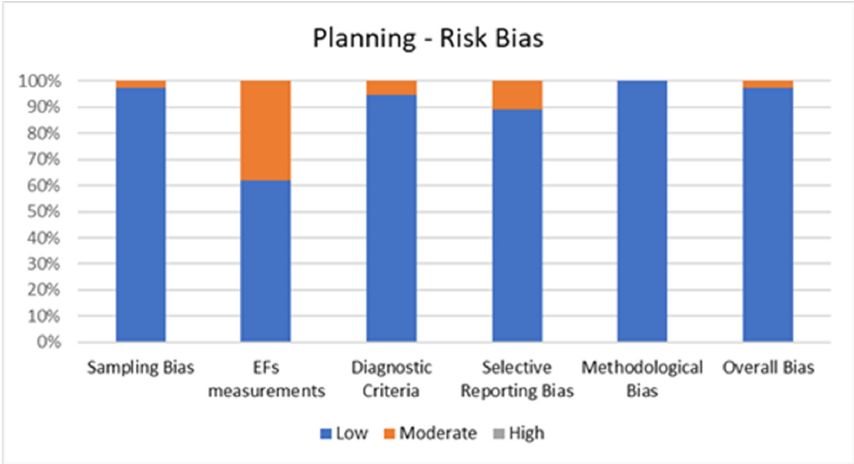
Figure 3. Risk of Bias for Planning.